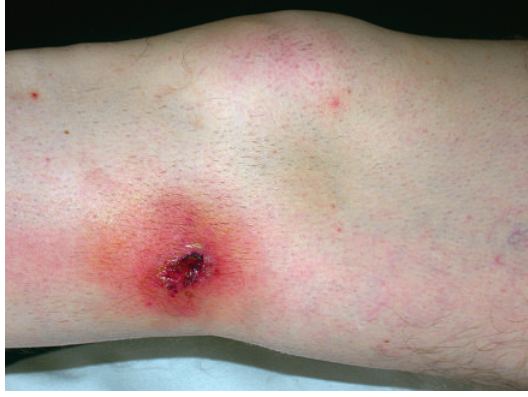
“Eschar” at the inner side of the right knee due to ulceroglandu- lar tularaemia in a young man after a tick bite (Zurich,